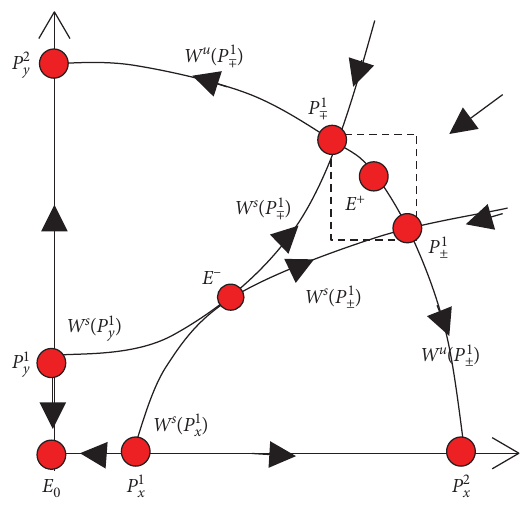
Figure 10: The visual illustration of Theorem